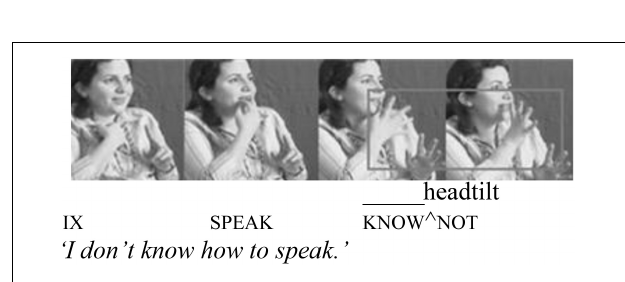
FIGURE 4 | Adapted with permission from Gökgöz (2009:20).